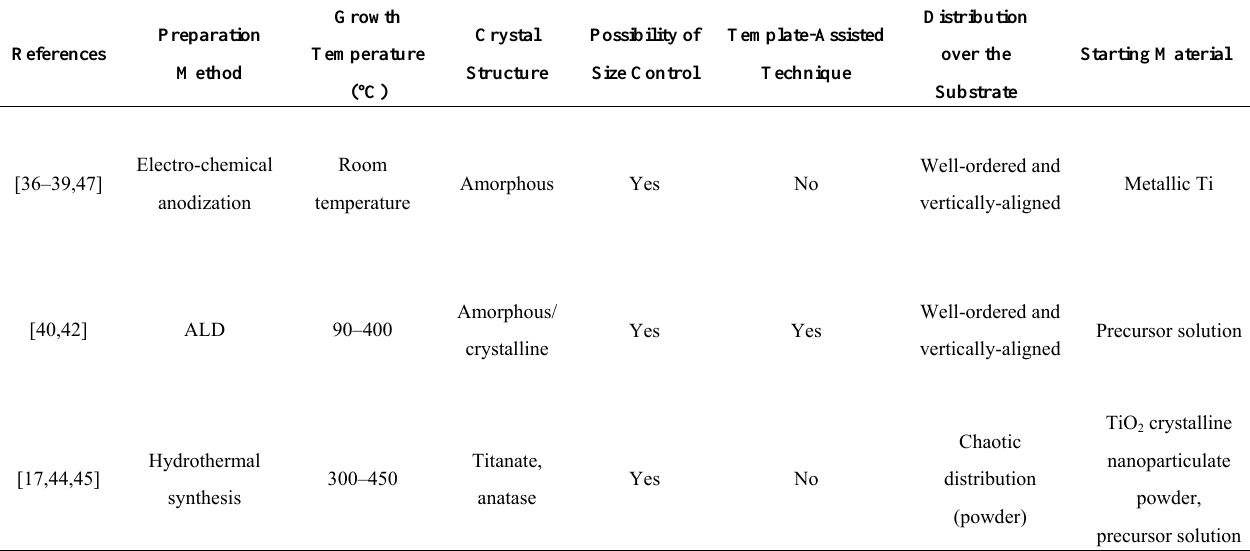
nanotube preparation methods. 2